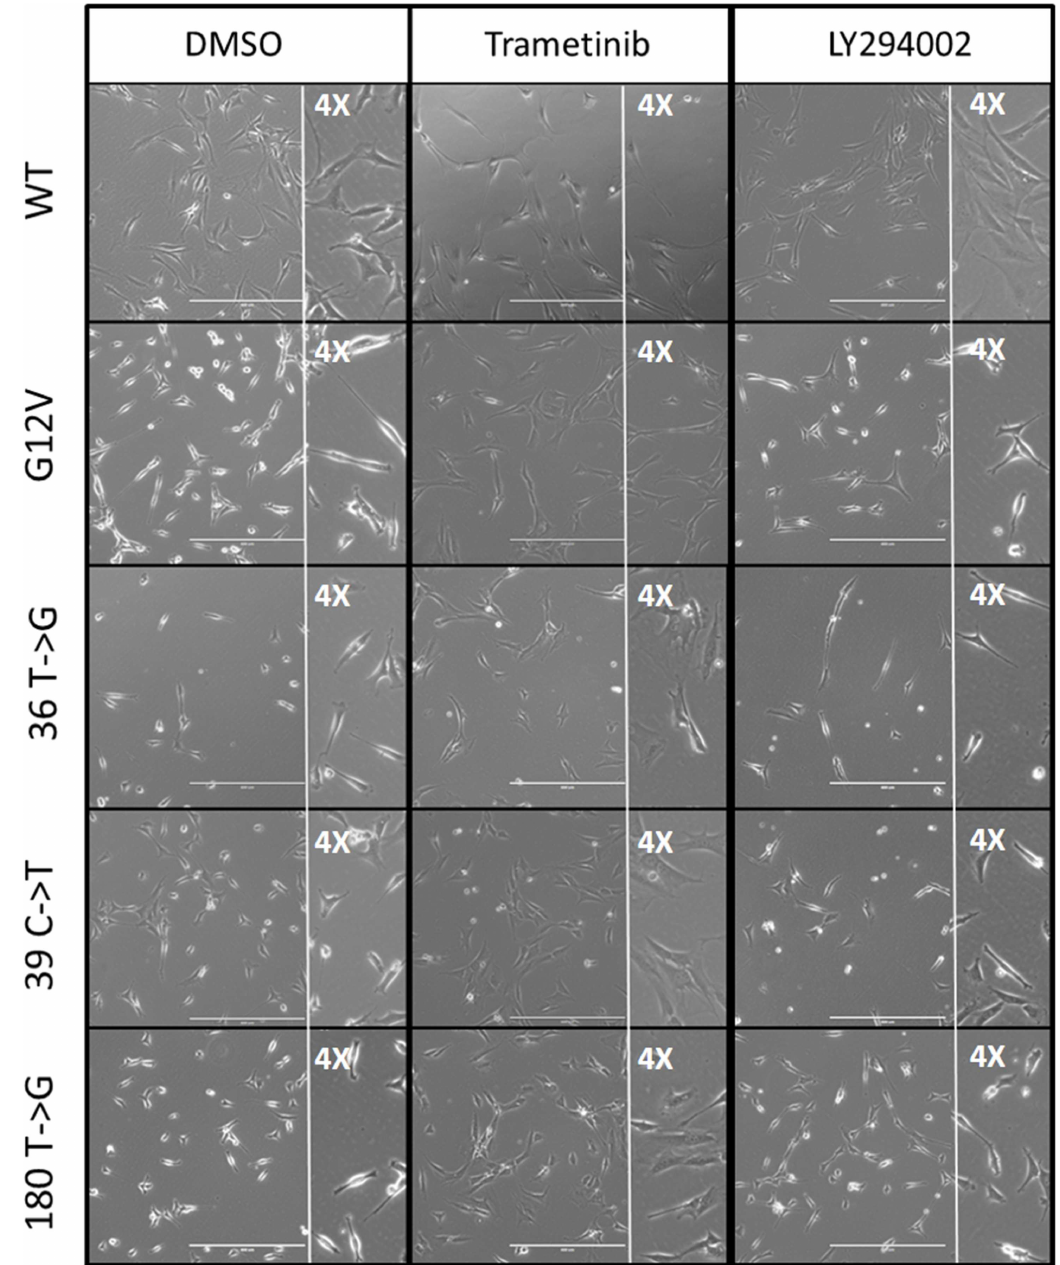
Fig 3. Refractile morphology of silent mutant cell lines was MAPK, but not PI3K, dependent. Cells were plated at low density and photographed with phase contrast microscopy before or after 24 hours of treatment. Left column: vehicle only. Center column: Mek 1/2 inhibitor (1 μ M trametinib). Right column: PI3K inhibitor(5 μ M LY294002). Insets are 4X views.